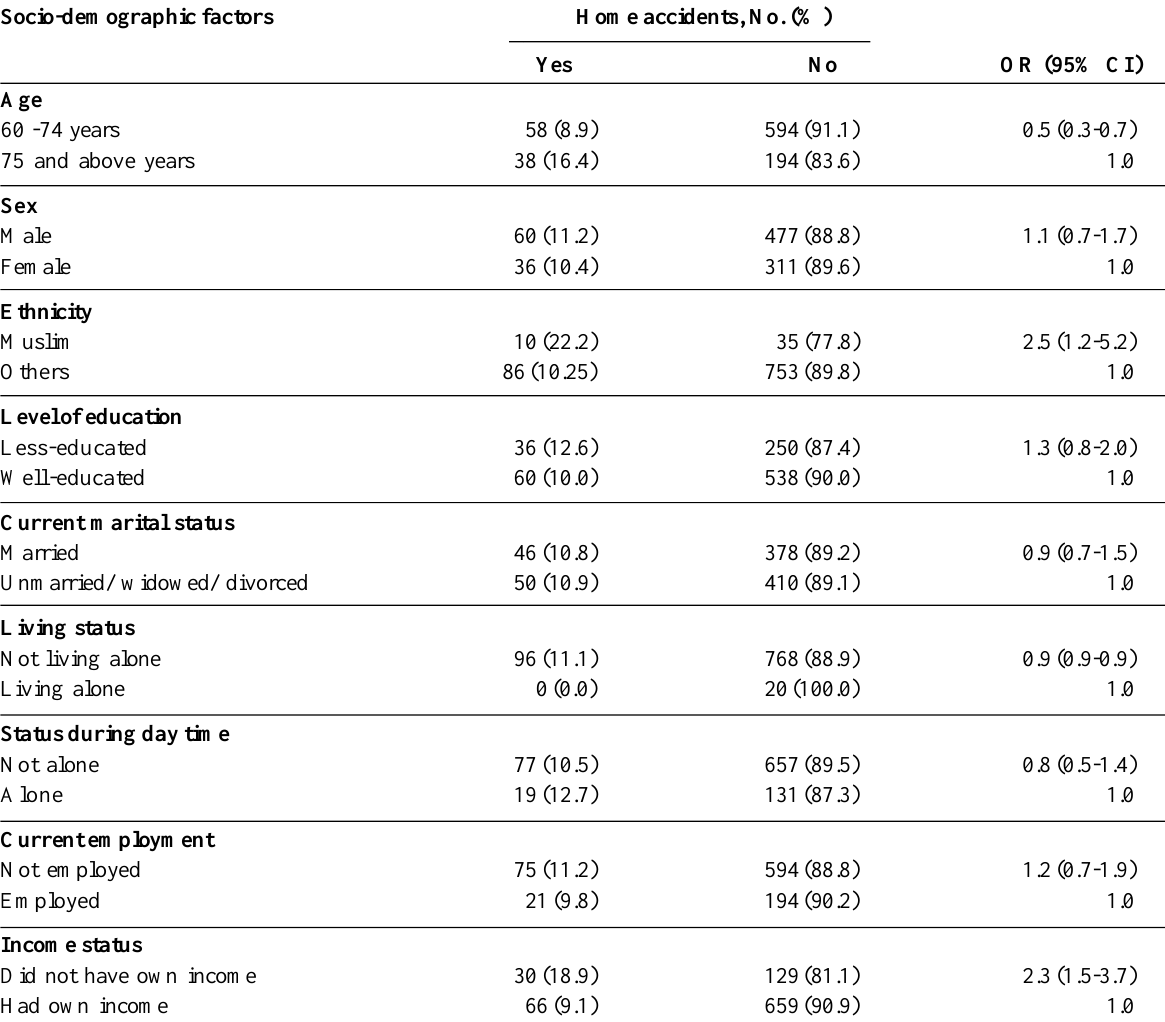
Table 1. Socio-demographic factors and the occurrence of home accidents in the sample Socio-demographic factors Home accidents, No.